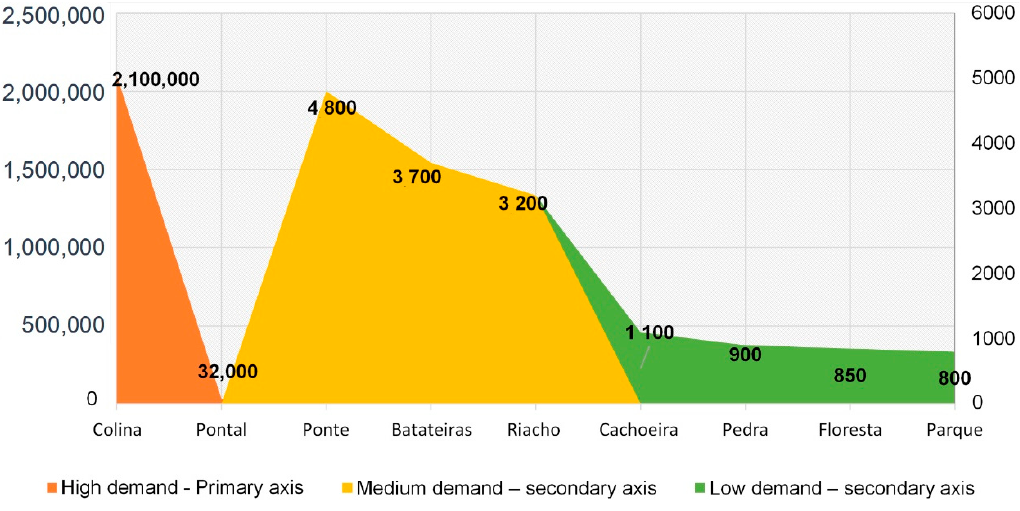
Figure 3. Demand of visitors to Araripe UGGp geosites—average of the period from 2016–2017.